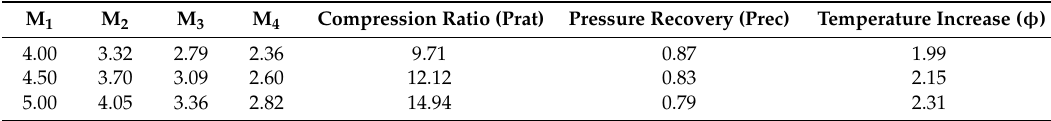
Table A2. Theoretical calculations for three ramp inlet.